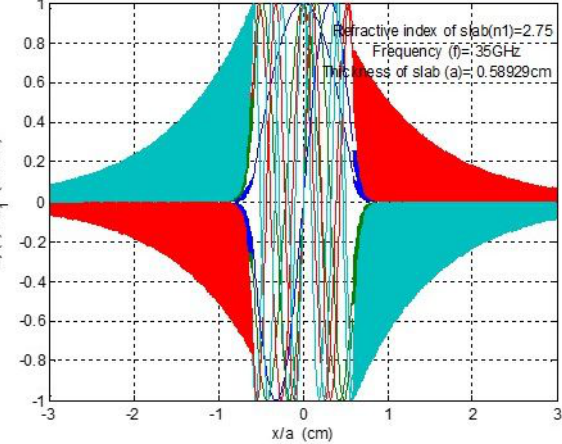
Figure 1: Electric field outlines as a function of (x/a) cm with continu- ous graphene thickness a = 0.58929 cm